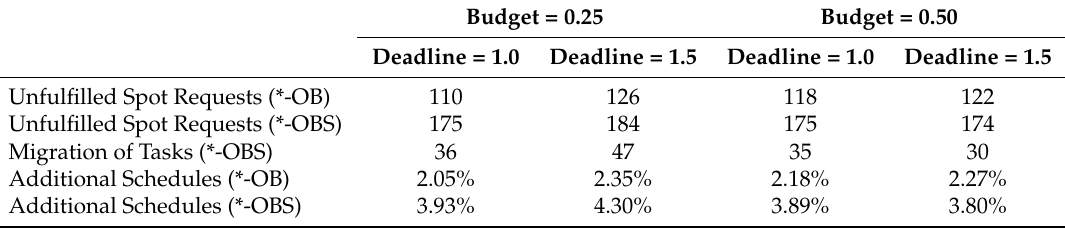
Figure 3. Characterization of the schedules regarding the instance pricing model. Table 3. Results for MISER in terms of number of occurrences of unfulfilled spot requests, for both *-OB and *-OBS configurations; migration of tasks, for *-OBS configuration; and additional schedules compared to *-O configuration, for both *-OB and *-OBS configurations, and for diverse deadline and budget QoS